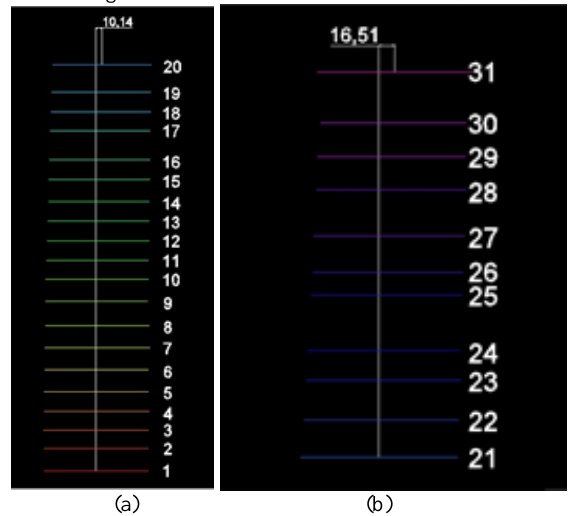
Figure 7. (a) Sections of the minaret from transition segment to balcony, (b) Sections of the minaret from balcony to spire